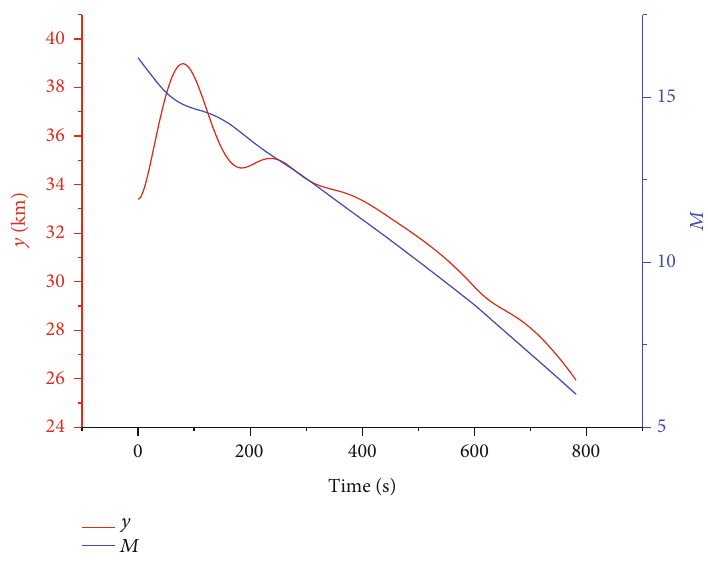
Figure 7: Altitude and Mach number with constant